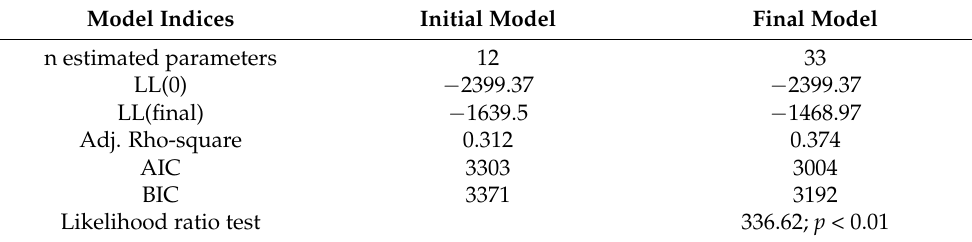
Table 5. Model fit comparison between the initial and the final